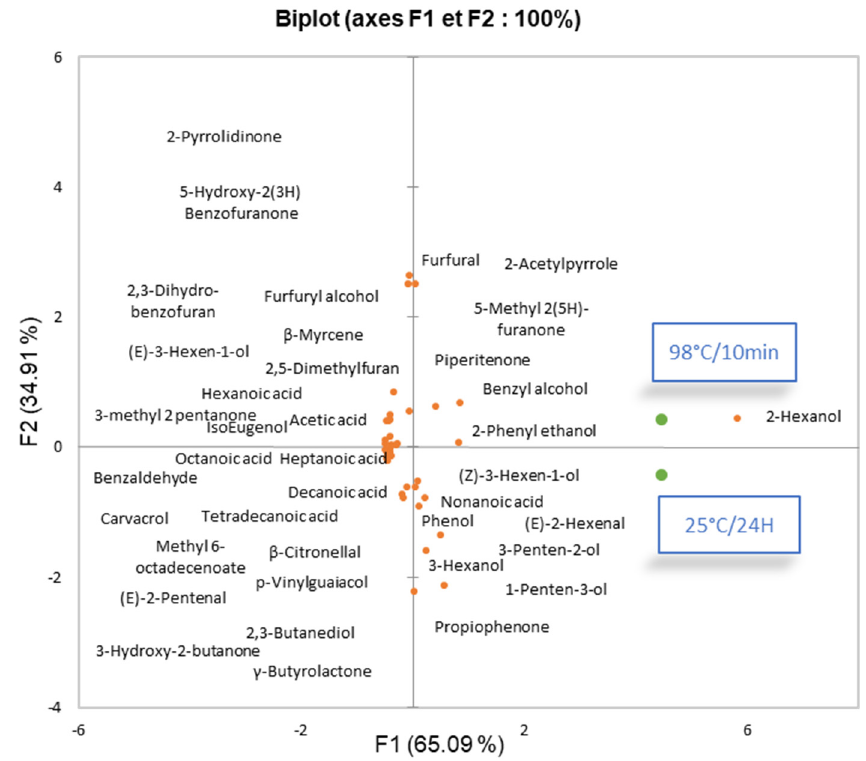
Figure 2. PCA biplot of aroma compounds in Kinkeliba herbal tea.